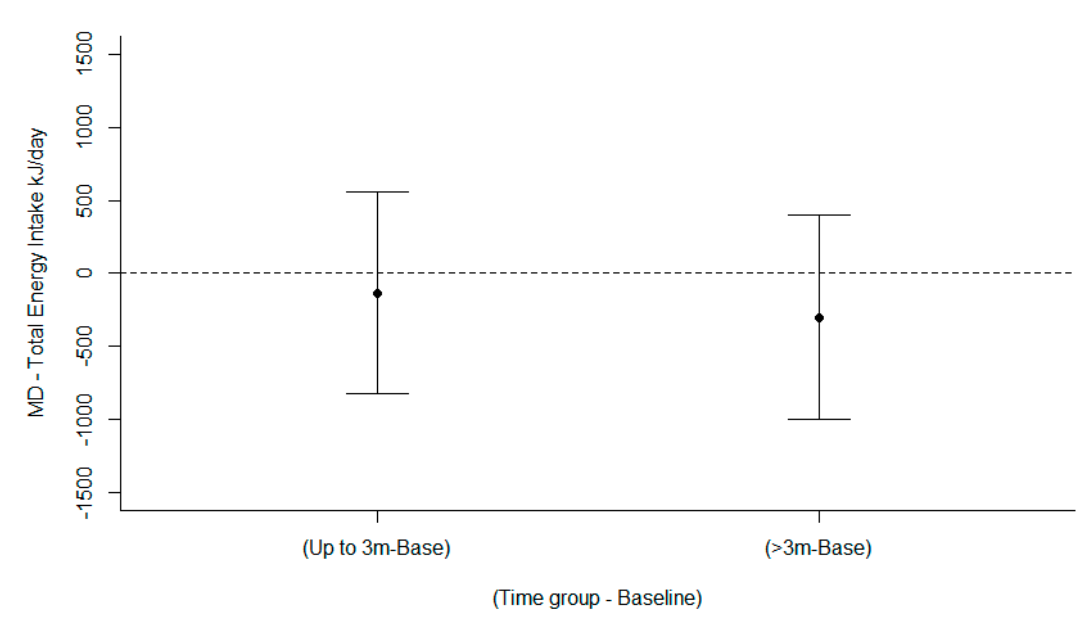
Figure 3. Mean di ff erences between arms in Total Energy intake (kJ / day) over Figure 3. Mean differences between arms in Total Energy intake (kJ/day) over time.